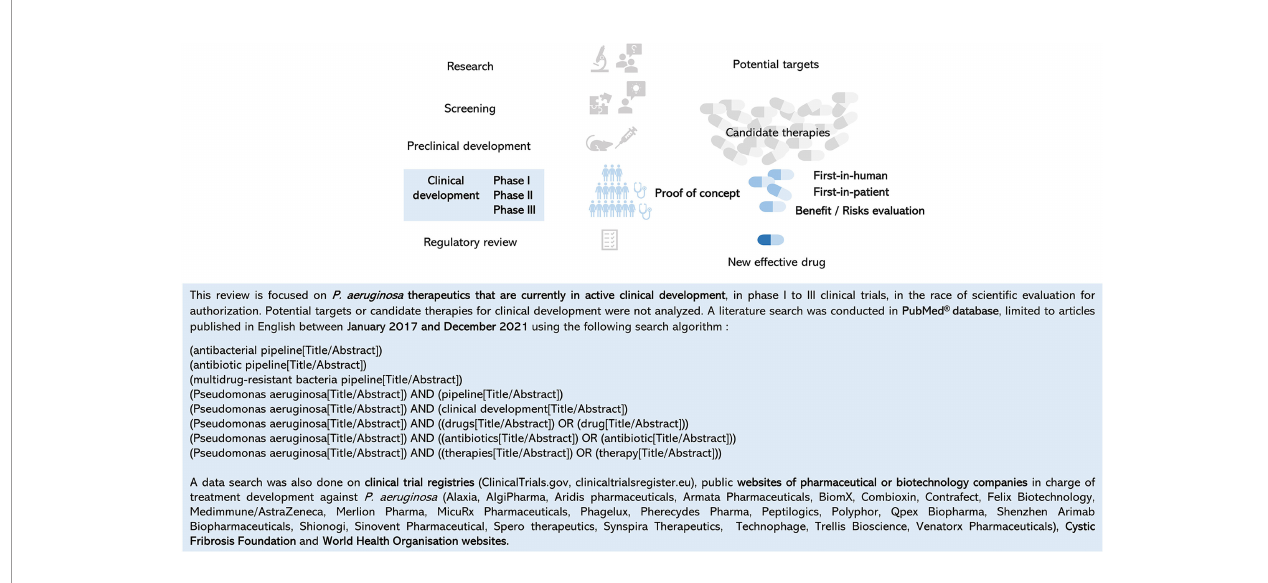
FIGURE 3 | Review focus, data search criteria, and